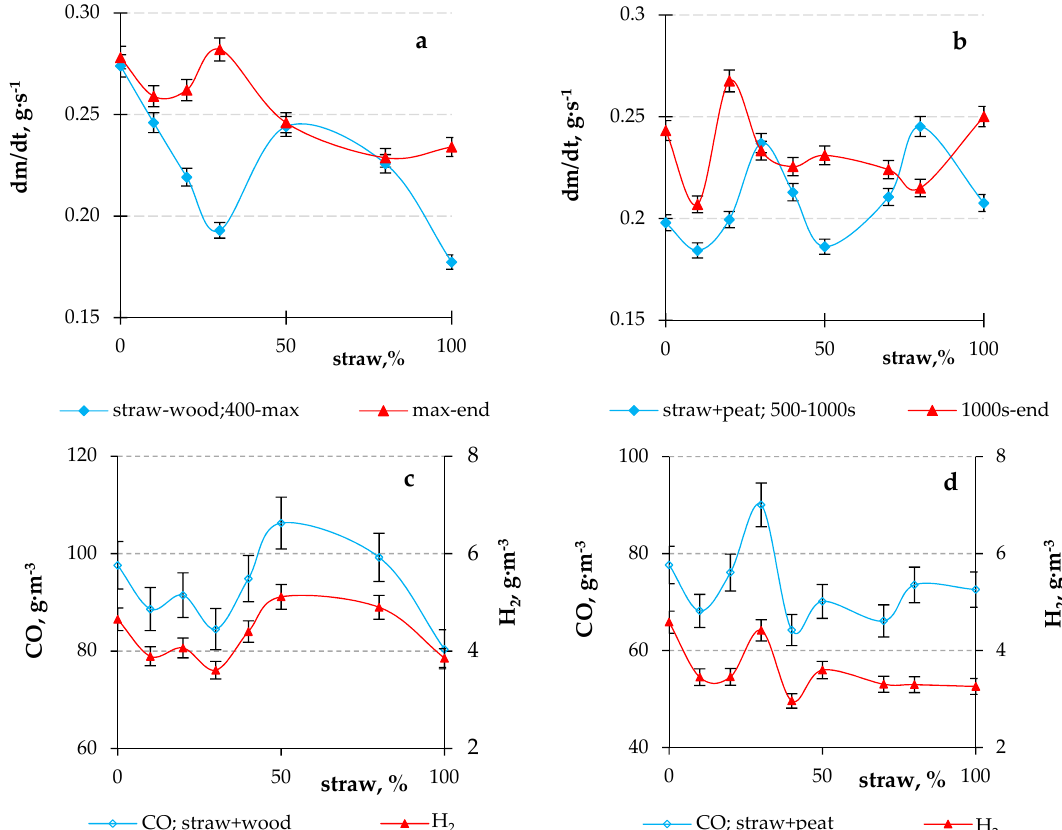
Figure 4. E ff ect of the wheat straw mass share wt.% in a mixture with wood ( a , c ) and with peat ( b , d ) Figure 4. Effect of the wheat straw mass share wt.% in a mixture with wood (a, c) and with peat (b, d) pellets on the biomass mass loss rates ( a , b ) at di ff erent stages of thermo-chemical conversion and on pellets on the biomass mass loss rates ( a,b ) at different stages of thermo-chemical conversion and on the flowing gas composition at the outlet of the gasifier ( c , d the flowing gas composition at the outlet of the gasifier ( c , d ).